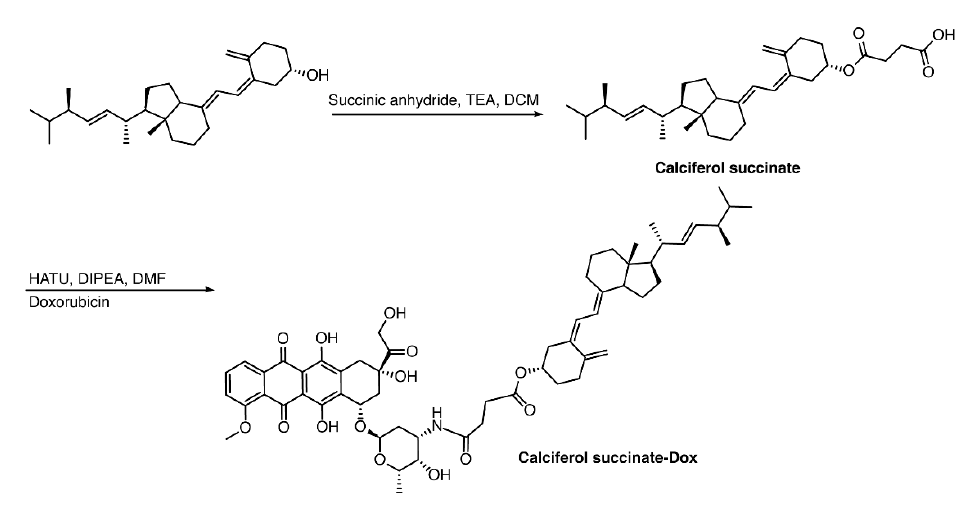
Figure 1. Chemical synthesis of DOX-Vit D.